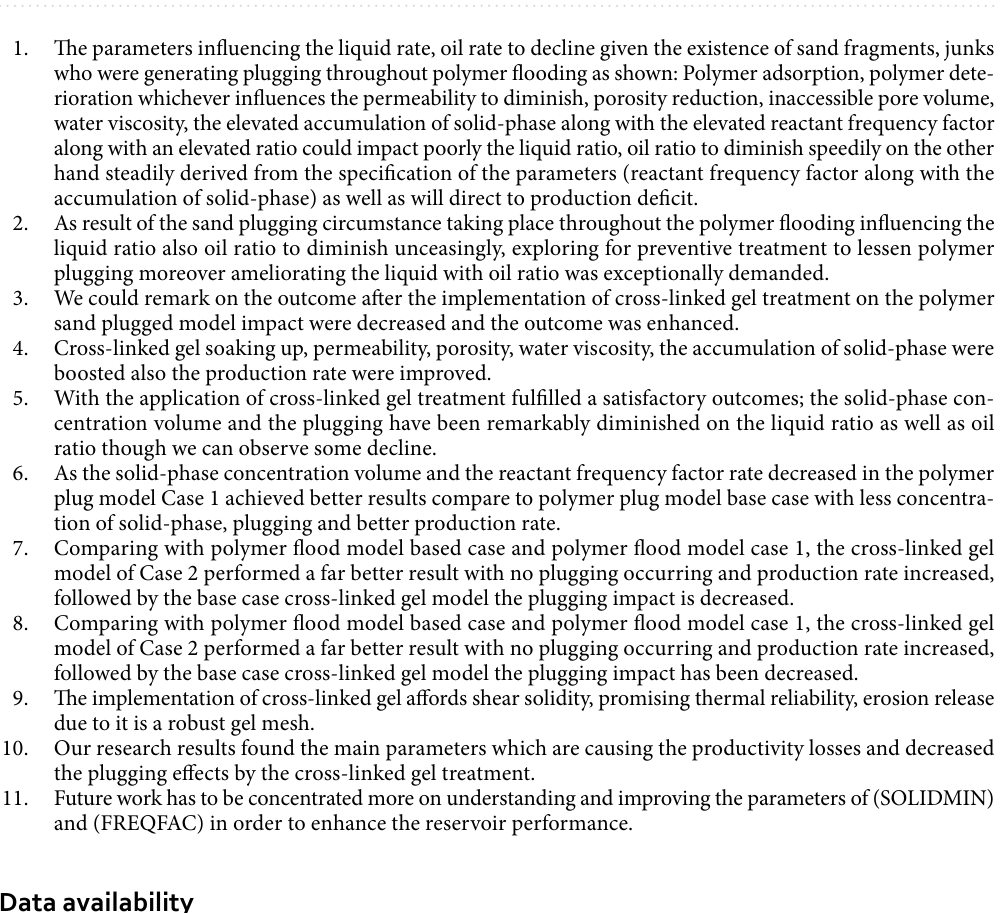
Figure 27. Shows the oil ratio afterwards the cross-linked gel treatment graph CMG STARS 2017.10 URL: https:// www. cmgl.